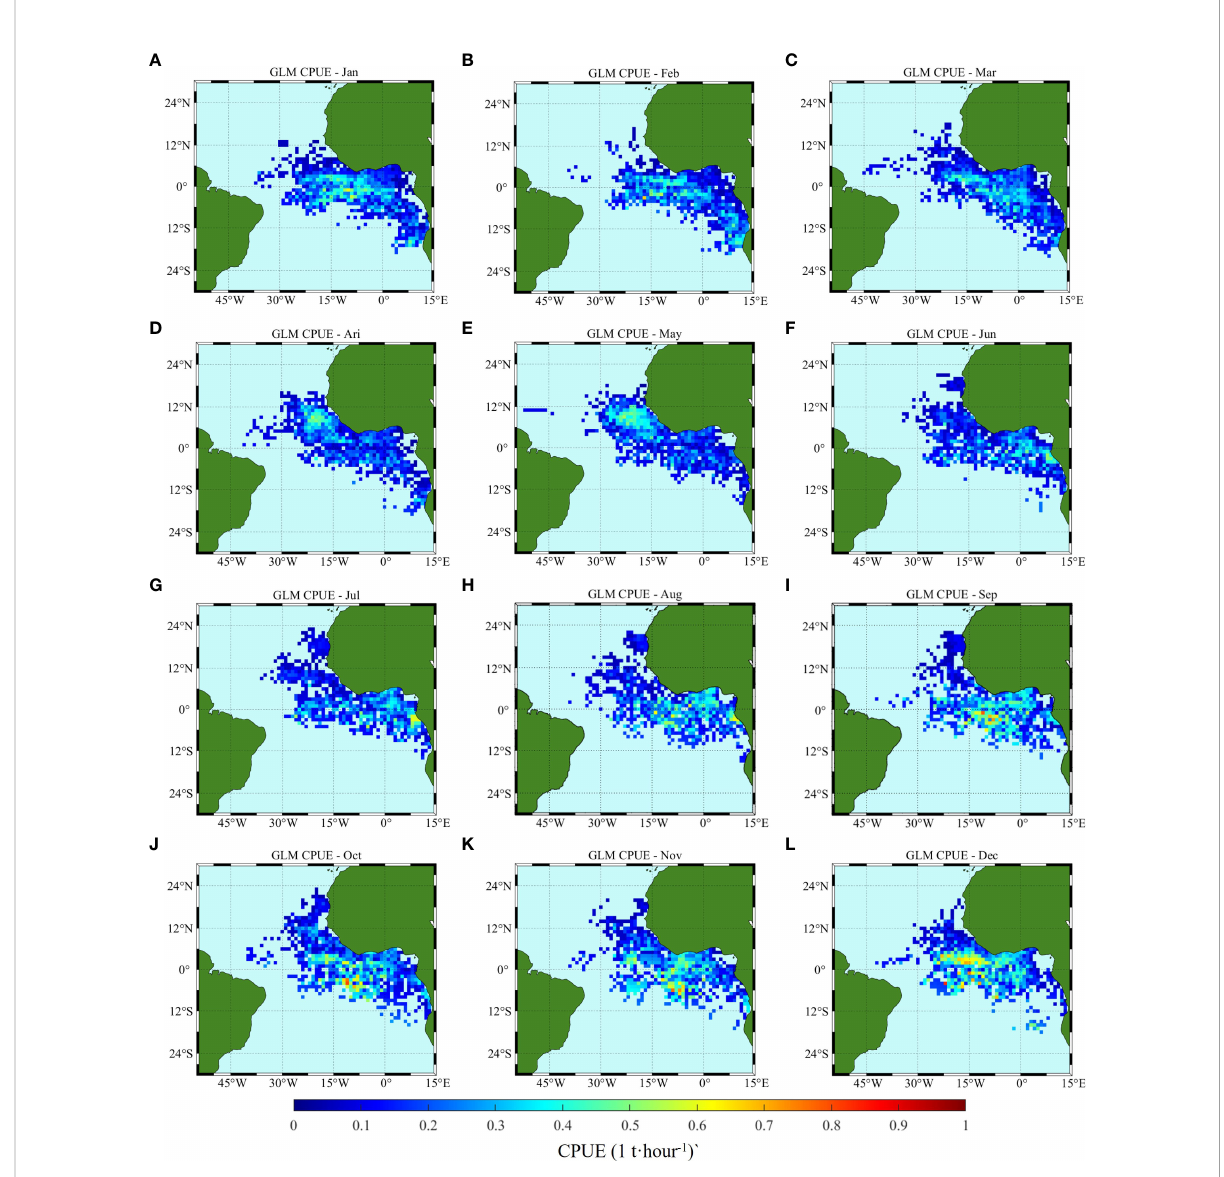
FIGURE 9 Climatology monthly spatial distribution of CPUE predicted by GLM, (A – L) correspond to January to December,